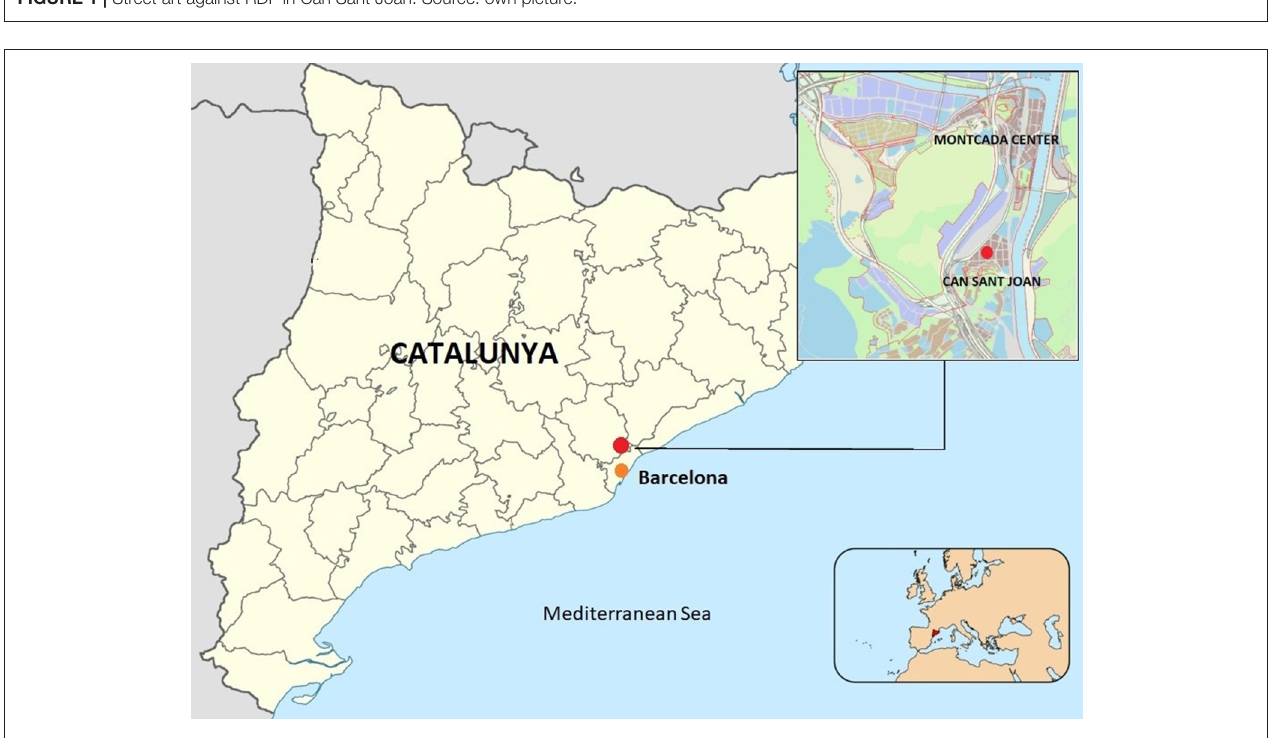
FIGURE 2 | Geographical location of Can Sant Joan. Source: own